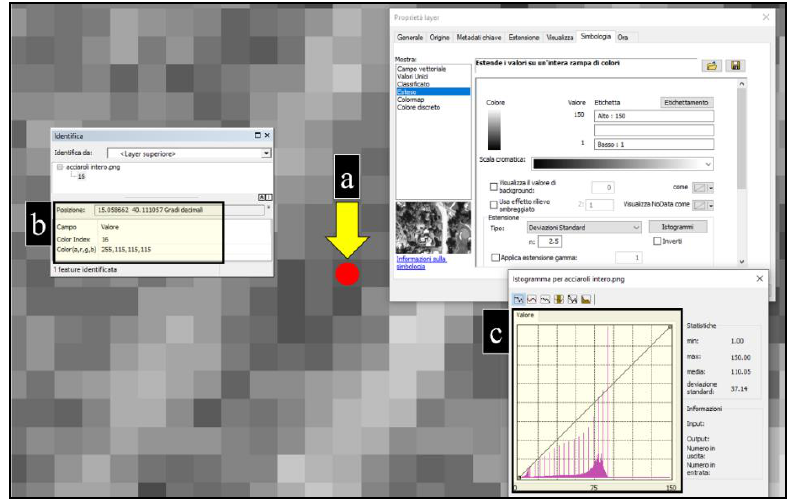
Figure 2. Example of rhodolith deposits definition by ArcGis 10.7.1 software (Acciaroli B site): ( a ) ROV point on backscatter pixel. ( b ) Colour index and associated RGBA. ( c ) Frequency histograms of pixels’ colour index in the side-scan sonar (SSS) image (frequencies range from 0 to 90). Seabed videos were made through a ROV (“Perseus” of Ageotec) equipped with a high